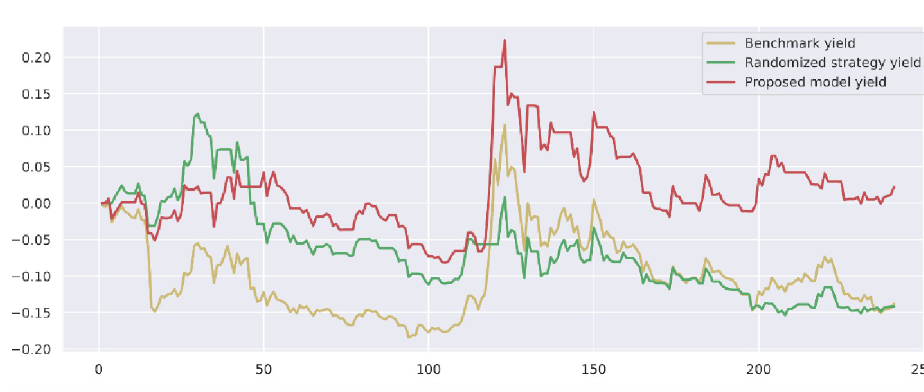
Fig 10. CSI 300 constituent stock strategy returns.